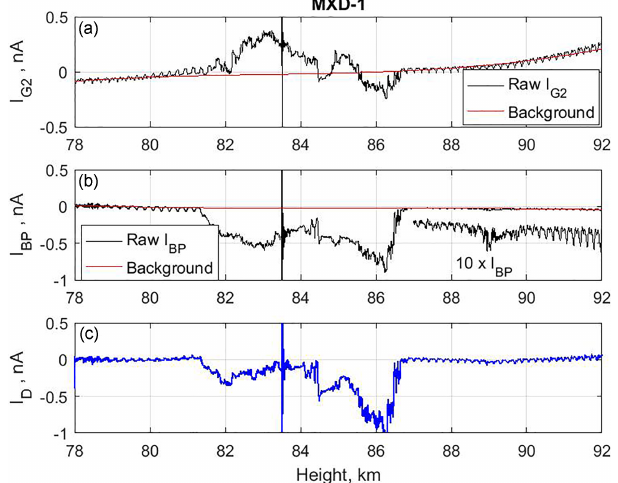
Figure 3. The smoothed currents I G2 and I BP and the assumed background currents are shown in panels (a) and (b) . In panel (c) we show the I D current based on the currents I G2 and I BP , cor- rected for background. The “event” at ∼ 83 . 5km is due to a squib being fired to open another instrument on the payload. In panel (b) we have also plotted a current 10 × I BP to emphasize that there is a clear but weak dust structure at least spanning the altitude region from ∼ 88 . 5 to ∼ 89 .